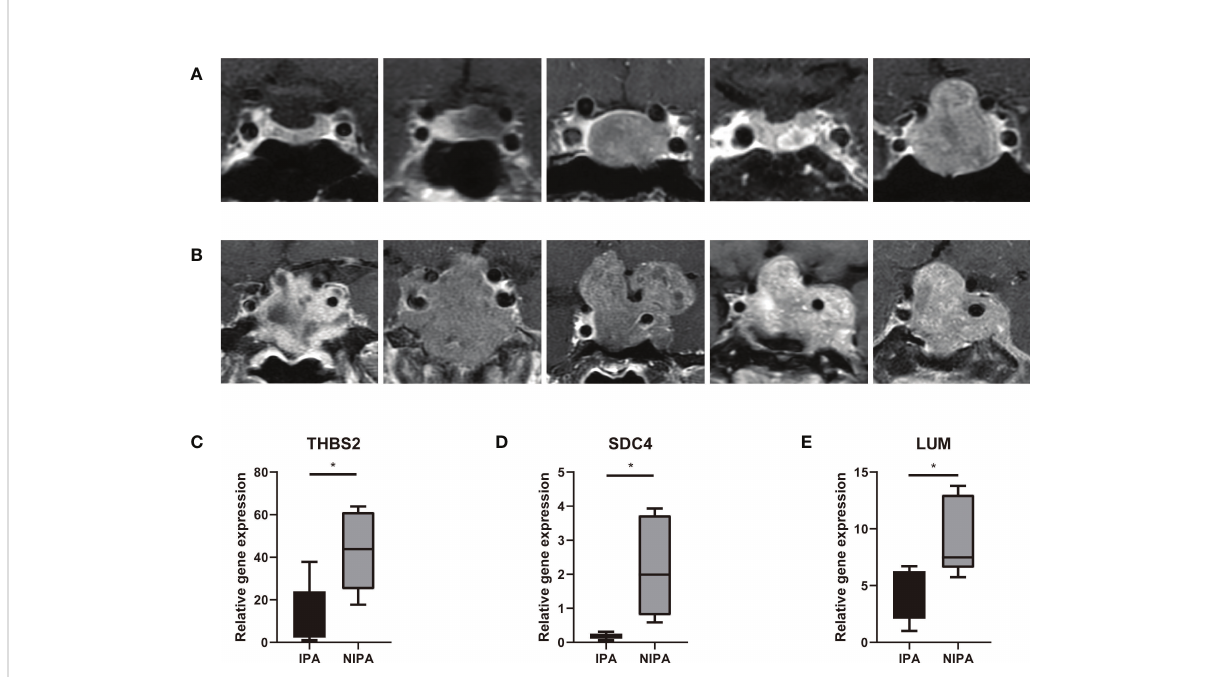
FIGURE 9 qPCR detection. (A) Preoperative MRI scans from fi ve patients with NIPAs. (B) Preoperative MRI scans from fi ve patients with IPAs. (C – E) Expression levels of THBS2 , SDC4 and LUM in IPA and NIPA tissues along with statistical results arising from unpaired t-tests, * indicates P <